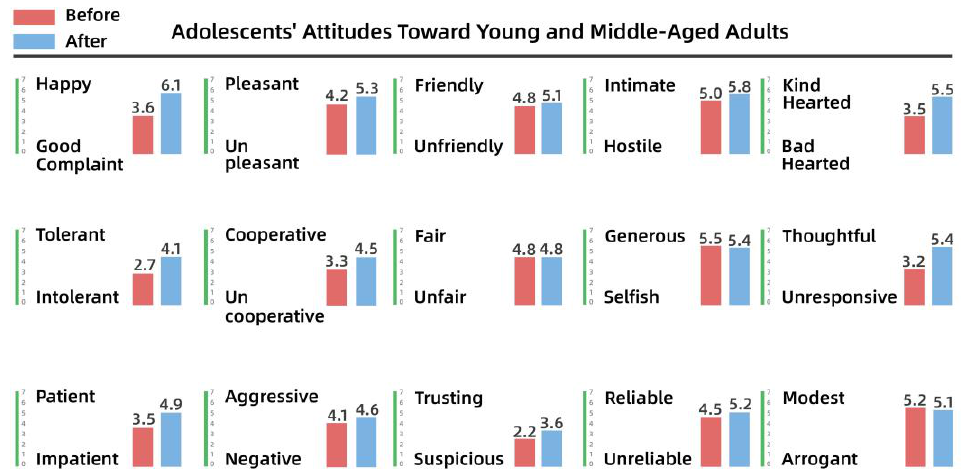
Figure 8. Adolescents’ attitudes toward young and middle-aged adults.